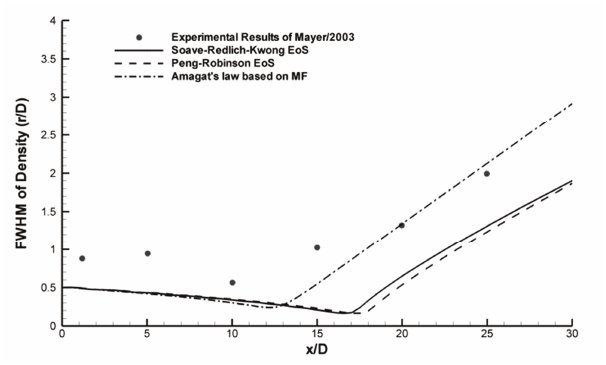
Fig. 8. Axial density distribution for transcritical case From the results of the full width of half maximum of density, it can be obtained the tangent by linear interpola- tion which represents the jet expansion rate. The linear interpolation was performed by other authors between x/D = 15 and x/D = 25. In the present work these were generally the points chosen for the calculation, however as it is visi- ble, for the current approach at transcritical conditions, the jet expansion starts only after x/D = 15, thus, for this situa- tion the interpolation was performed between x/D = 20 and x/D = 30. These results are expressed in Table 2.